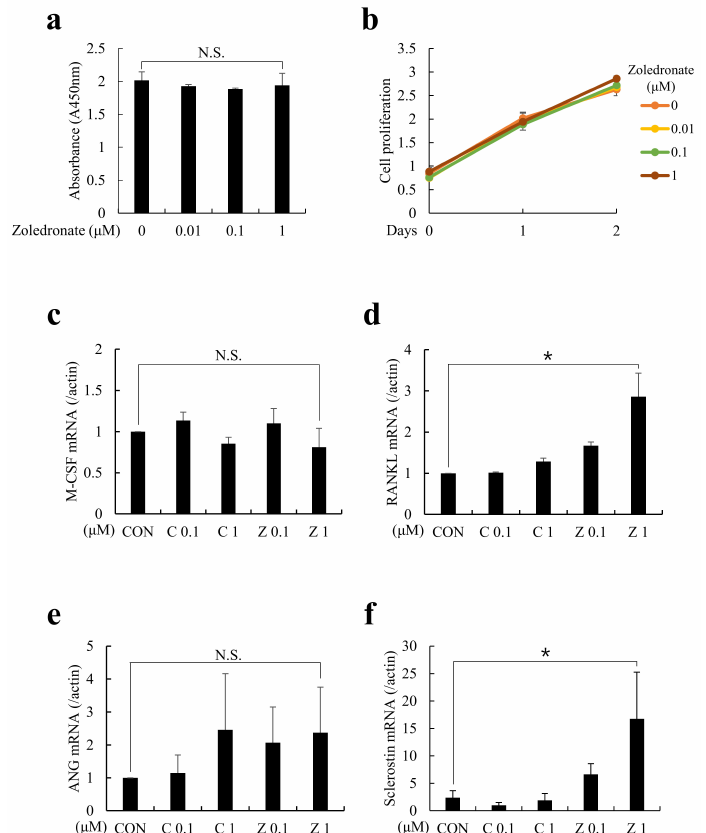
Figure 1. Zoledronate increased receptor activator of nuclear factor kB ligand (RANKL) and sclerostin mRNA expressions in MLO-Y4 cells. MLO-Y4 cells were cultured in the presence of indicated doses of clodronate (C, 0.1 or 1 µ M) or zoledronate (Z, 0.1 or 1 µ M) for 48 h. ( a , b ) Effects of increasing concentrations of zoledronate on MLO-Y4 cells. Cell Counting Kit-8 (CCK-8) assay showed that zoledronate did not reduce cell viability at all concentrations. ( c – f ) At the end of culture, total RNAs were isolated and the mRNA expressions of ( c ) Macrophage-colony stimulating factor (M-CSF), ( d ) RANKL, ( e ) angiogenin (ANG), and ( f ) sclerostin were examined by quantitative real-time PCR analyses. CON refers to the control vehicle, phosphate-buffered saline (PBS). The quantitative data are presented as mean ± SD (* p <